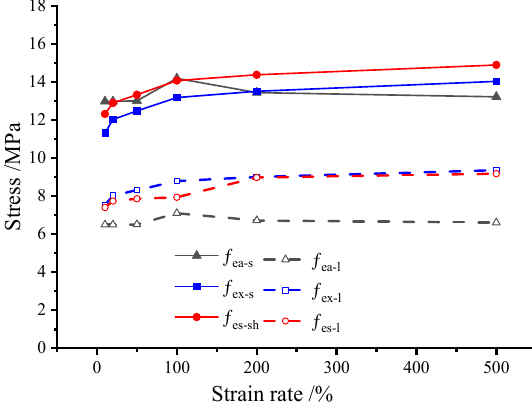
Figure 6. The comparison of individual design strengths.